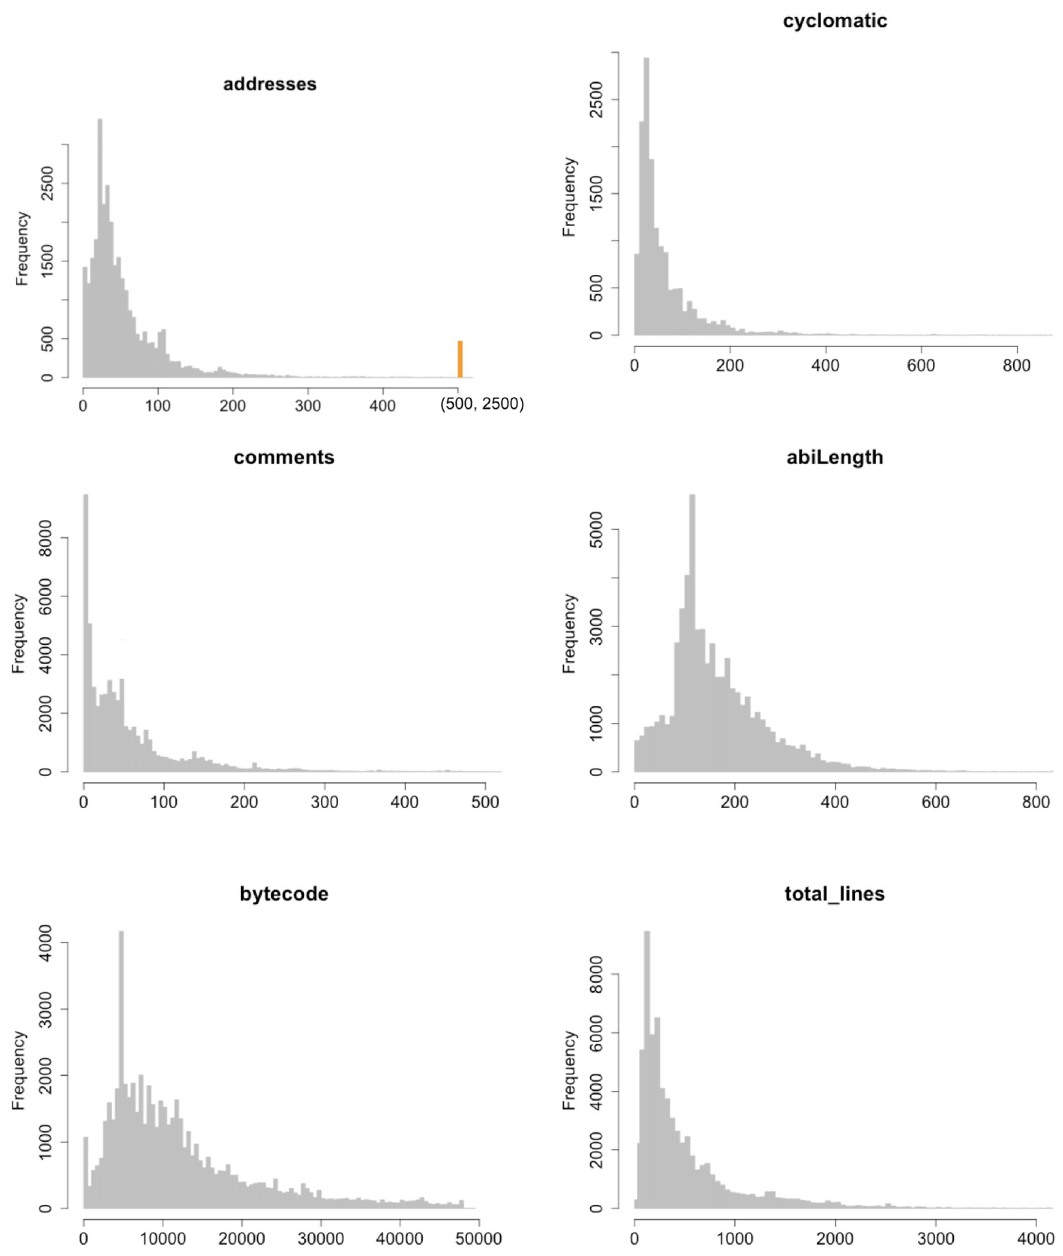
Fig 5. Histogram distributions of the metrics Address, Cyclomatic, Comments, ABI, Bytecode and